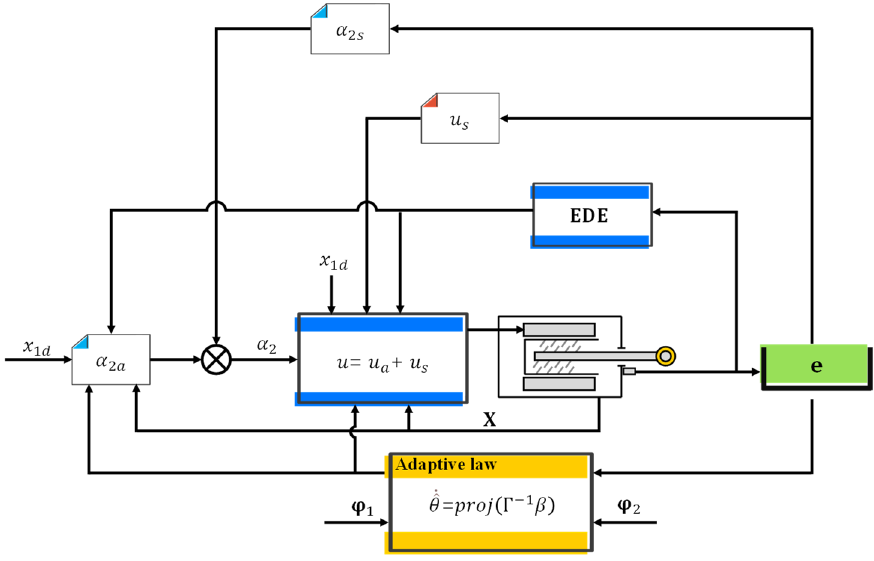
Figure 2. Diagram of Proposed ADRRAC Strategy.